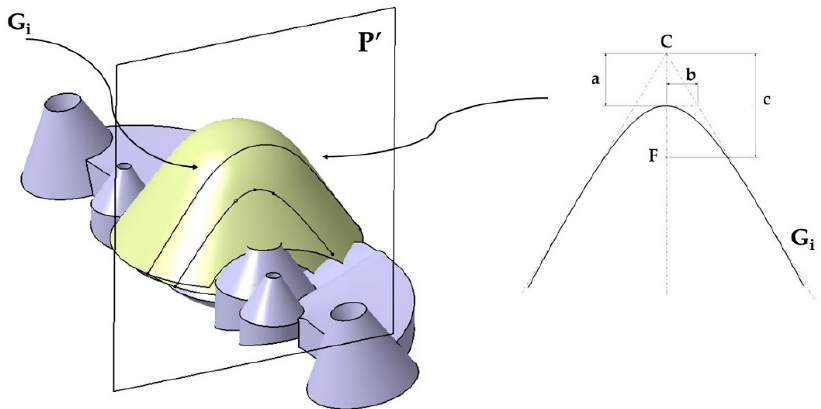
Figure 5. Representation of the curves G i obtained from the intersection of the plane P’ with the surfaces T, T’, C, C’.